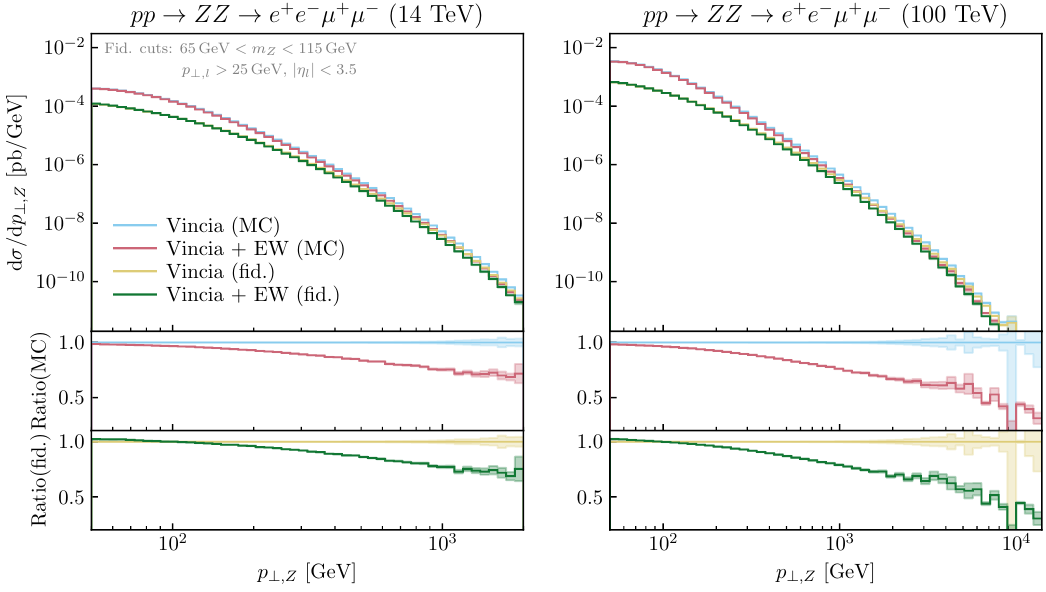
Figure 14: An illustration of the size of the EW virtual Sudakov logarithms gener- ated by Vincia’s EW shower in the process pp → ZZ at 14 TeV (left) and 100 TeV (right). Shown are the leading-order result without EW shower (blue) and with the EW shower (red) at the Monte Carlo level, as well as those same predictions at the fiducial level (yellow and green respectively).